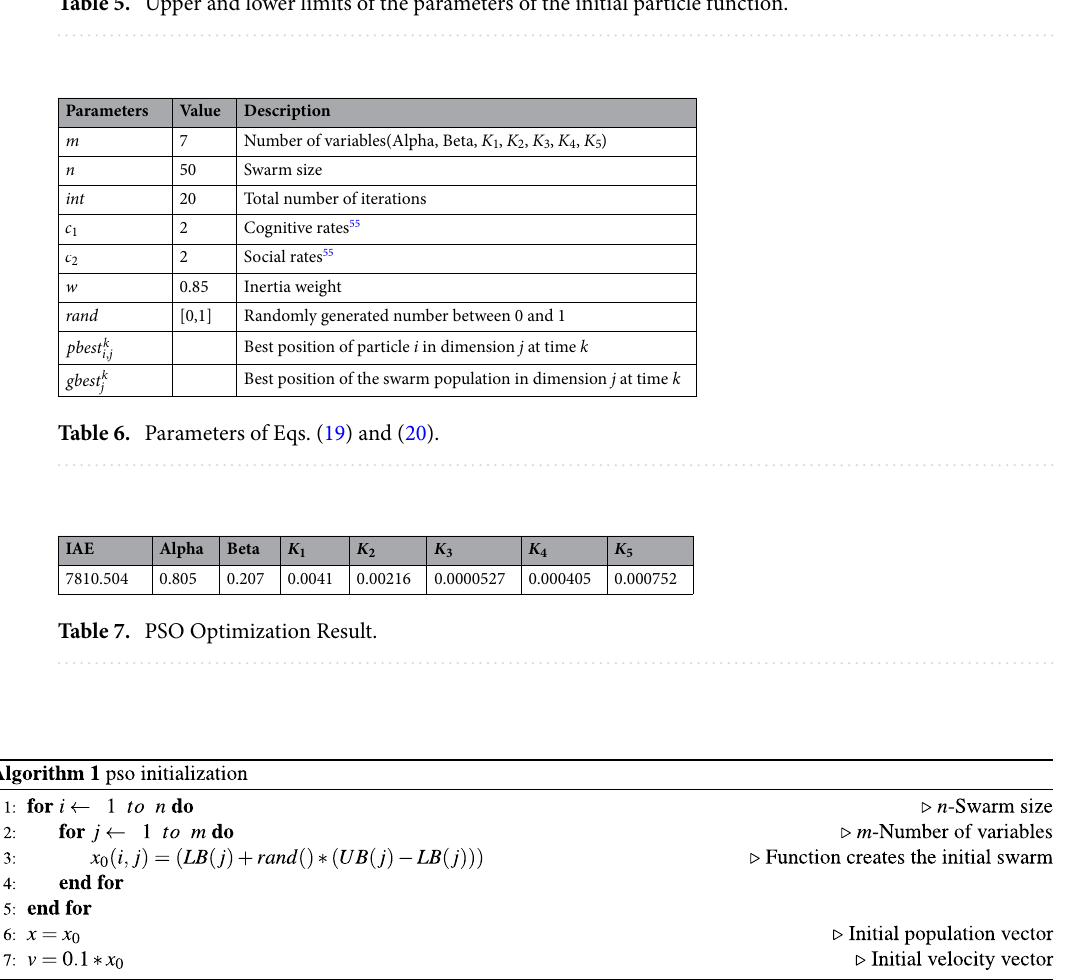
Table 5. Upper and lower limits of the parameters of the initial particle function.